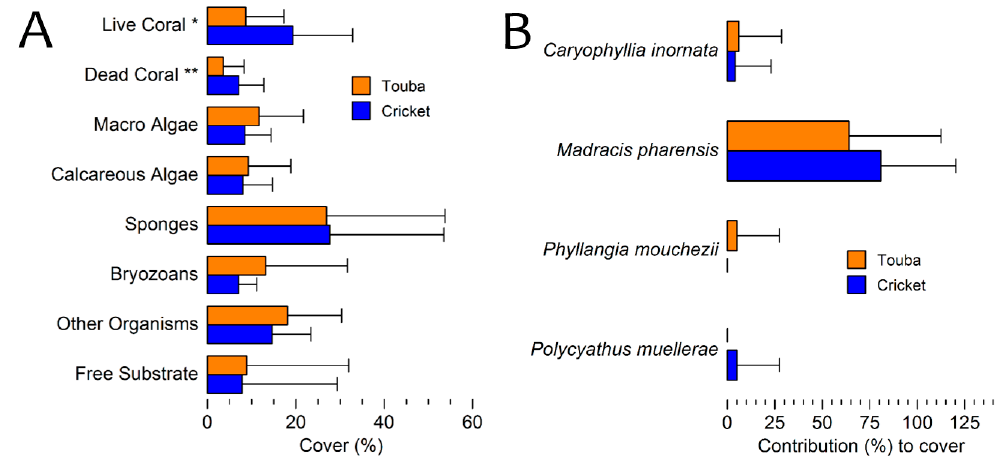
Figure 3. Percent benthic cover in 2010 at the Touba and Cricket wrecks according to ( A ) categories and ( B ) contribution (%) to coral cover of four species. * p = 0.01078; ** p = 0.01859.